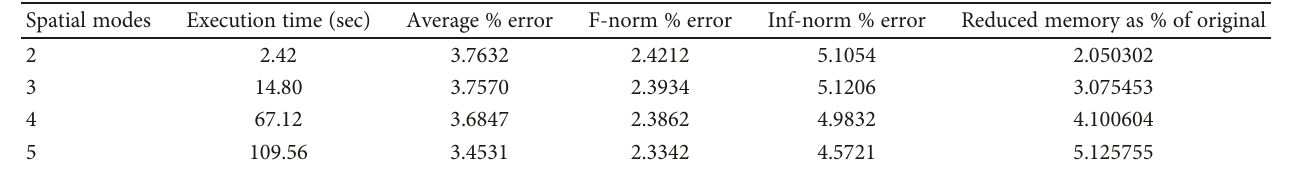
Table 10: Density in an y × z plane with i = 100